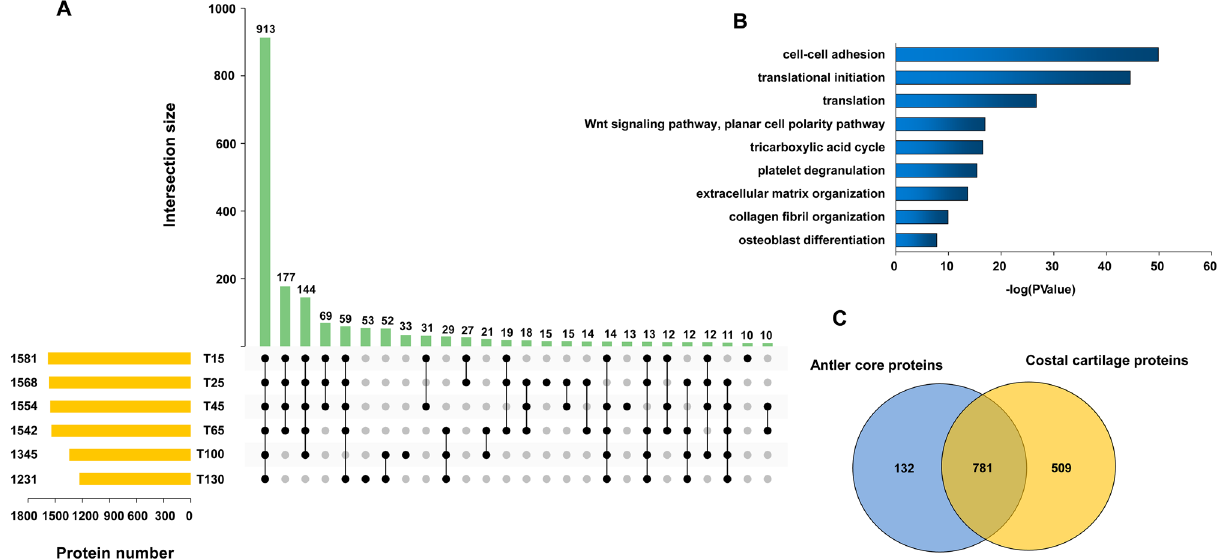
Figure 3. Overview of proteins identified for antler in different development stages and costal cartilage. ( A ) The upset plot diagram showing overlapping proteins identified from antlers in six different development stages. ( B ) The top nine terms of GO enrichment result for 913 antler core proteins. ( C ) The Venn diagram showing overlapping between antler core proteins and costal cartilage